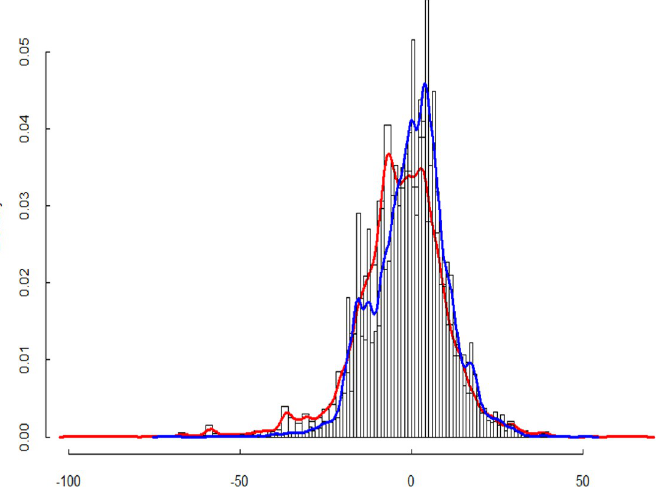
Fig 6. Slopes distribution of NKS under each environmental condition separately. Blue line for plots under rain-fed conditions. Red line for plots under controlled water deficit